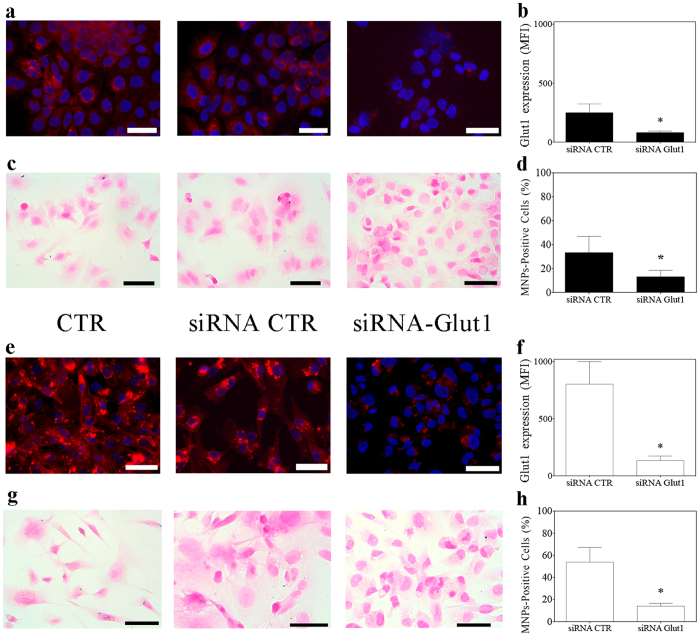
Direct inhibition of GLUT1 transporter via siRNA transfection reduces MNPs uptake in breast cancer cells.The effect of GLUT1 silencing via specific siRNA transfection is reported both as GLUT1 protein diminished expression (a,b,e,f) and as 2-NBDG MNPs diminished uptake (c,d,g,h). (a,e) epi-fluorescence images of GLUT1 protein expression (in red) in MCF7 (a) and MDA-MB-231 (e) cells, respectively. The decrease of GLUT1 protein expression on breast cancer cells, has been quantified as mean fluorescence intensity (MFI). (b,f) the fluorescence quantification of images in a and e, respectively, is reported for both treatment (siRNA CTR: scrambled small interfering RNA). (c,g) The effect of GLUT1 silencing on 2-NBDG MNPs uptake has been evaluated by counting the fraction of Prussian-blue positive cells after the Perls’ iron staining. (d,h): quantification of the fraction of MCF7 (d), MDA-MB231 (h) cells showing MNPs internalization (number of cells counted per sample: > 300). All data are presented as mean ± standard deviation. *p < 0.01 vs. siRNA CTR samples (t-test). Scale bars: 50 μm.